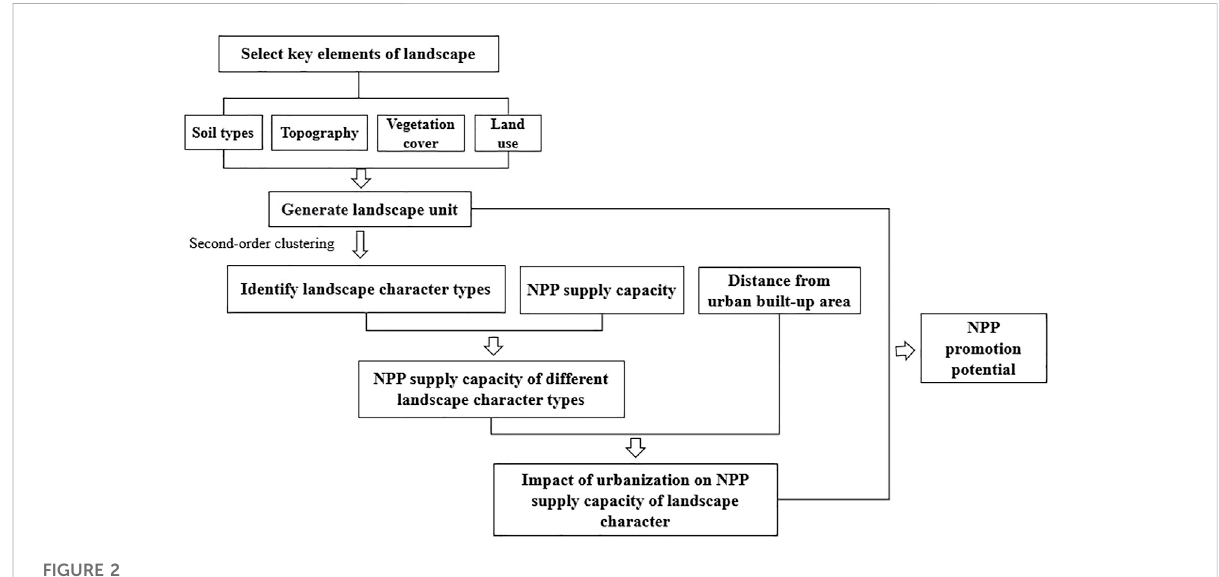
FIGURE 2 Research framework.